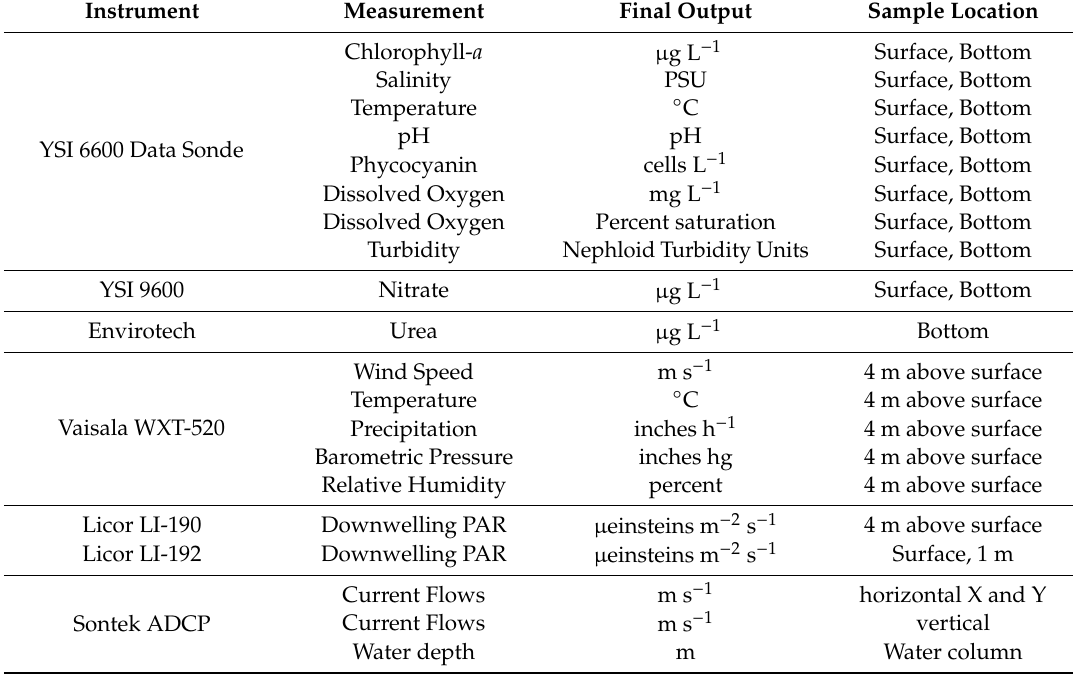
Table 1. Instruments, with associated parameters measured, final output, and sampling depth, installed on the MARVIN platform during the 2009 Sarasota Bay